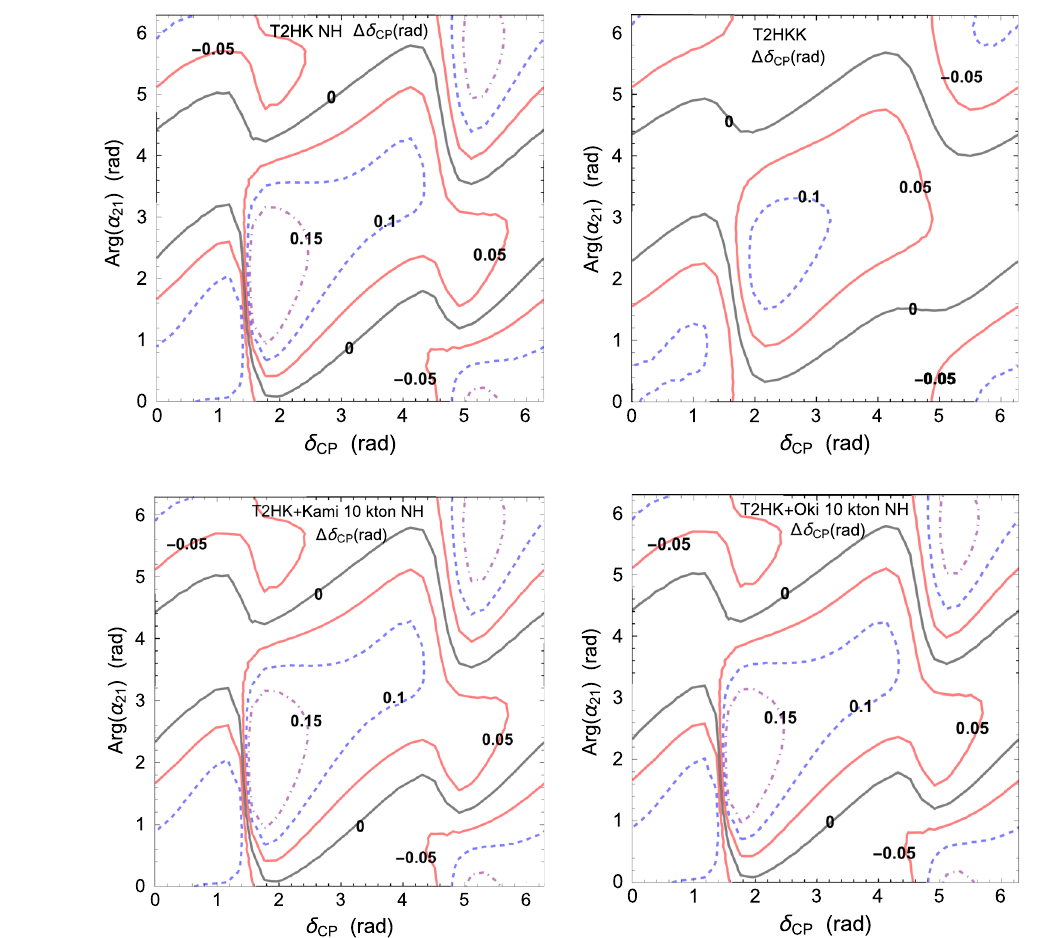
Fig. 3 The difference between the true value of δ CP , and the value that minimizes χ 2 ((cid:20)) of Eq. (32) with true mass hierarchy. The bench- mark with Eq. (26) is assumed, and the true mass hierarchy is normal. The upper-left, upper-right and lower-right subplots correspond to the T2HK, the T2HKK, and the plan of the T2HK plus a 10 kton water